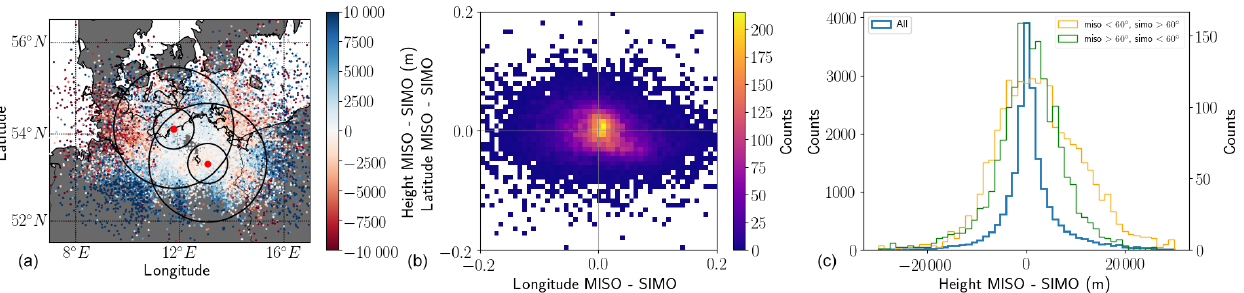
Figure 9. Comparisons of MIMO-CW MISO-like and MIMO-CW SIMO-like: (a) latitude and longitude distributions color-coded with altitude differences, (b) 2-D histograms of differences in latitude and differences in longitude color-coded on a linear scale, and (c) histograms of altitude difference using all common detections (using left y axis). In (c) we also show the altitude difference histograms for MISO zenith angles lower than 60 ◦ and SIMO zenith angles greater than 60 ◦ (yellow), as well as for MISO zenith angles greater than 60 ◦ and SIMO zenith angles less than 60 ◦ (green) using the right y axis. The loci of 30 ◦ and 60 ◦ zenith angles, with respect to each site, are indicated with black circles in the left